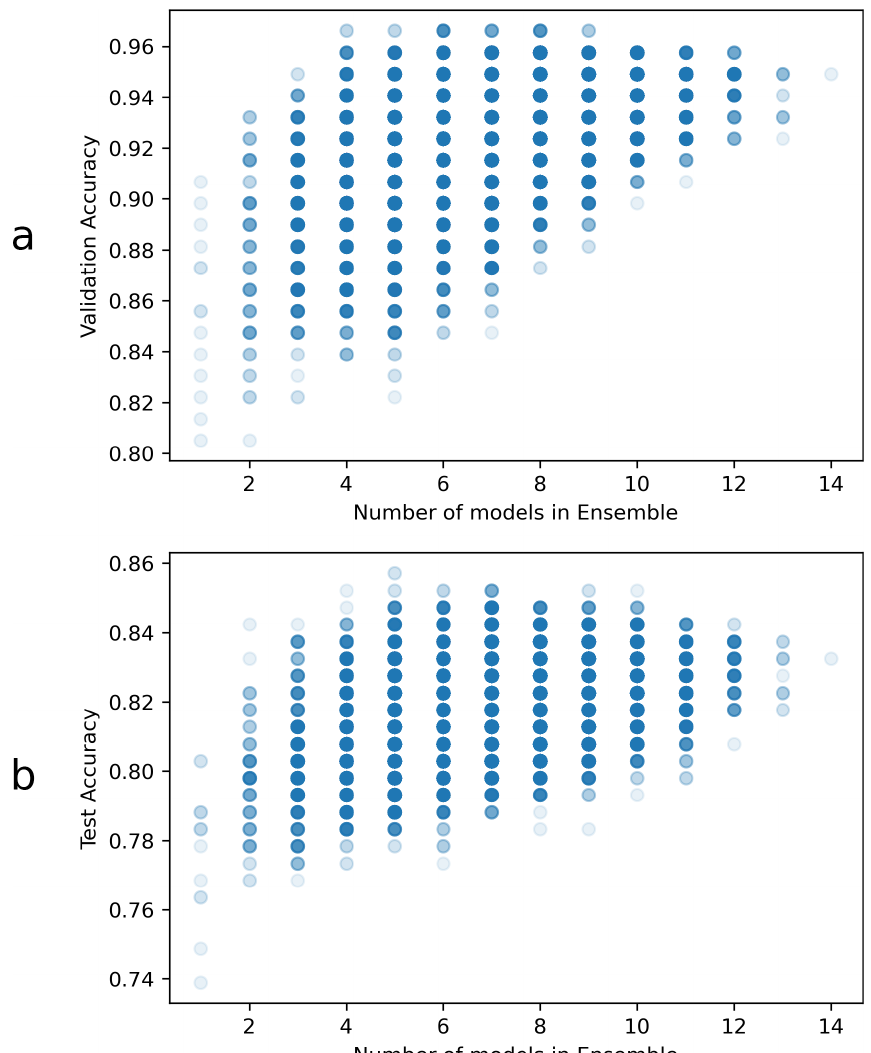
Figure 3. Ensemble accuracies: ( a ) Validation and ( b ) test accuracies, as well as the number of models per ensemble. Each point in these plots might have overlapping ensembles, so the markers have transparency to aid in visualization. A total of 16,383 different ensemble combinations were tested in this way. Notably, the validation results are used for ensemble selection, and the test accuracies are just included here for